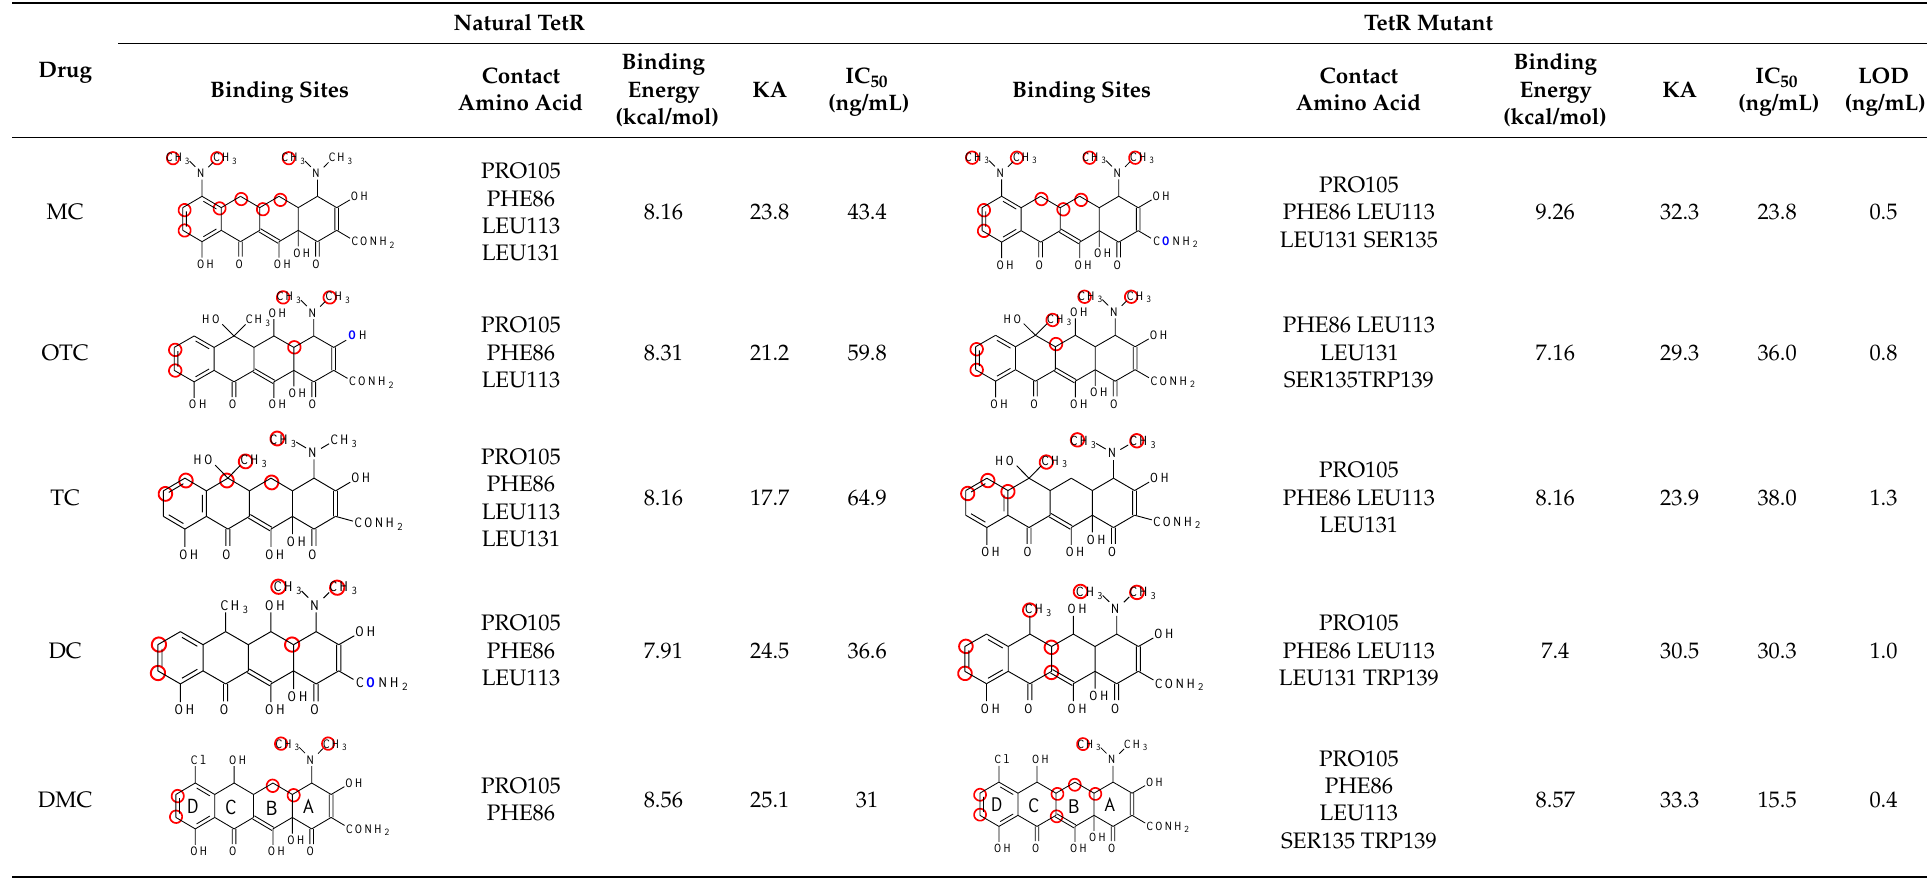
Table 1. Molecules, docking results, absolute affinity constants (KA) and determination parameters for the 10 TCs. The circled positions were the binding sites of the Table 1. Molecules, docking results,absolute affinity constants(KA) and determination parametersfor the 10 TCs. The circled positions were the binding sites of Table 1. Molecules, docking results,absolute affinity constants(KA) and determination parametersfor the 10 TCs. The circled positions were the binding sites of Table 1. Molecules, docking results,absolute affinity constants(KA) and determination parametersfor the 10 TCs. The circled positions were the binding sites of Table 1. Molecules, docking results,absolute affinity constants(KA) and determination parametersfor the 10 TCs. The circled positions were the binding sites of Table 1. Molecules, docking results,absolute affinity constants(KA) and determination parametersfor the 10 TCs. The circled positions were the binding sites of Table 1. Molecules, docking results,absolute affinity constants(KA) and determination parametersfor the 10 TCs. The circled positions were the binding sites of Table 1. Molecules, docking results,absolute affinity constants(KA) and determination parametersfor the 10 TCs. The circled positions were the binding sites of Table 1. Molecules, docking results,absolute affinity constants(KA) and determination parametersfor the 10 TCs. The circled positions were the binding sites of hydrophobic bond. The atoms highlighted with blue were the binding sites of the hydrogen bond. the hydrophobic bond. The atoms highlighted with blue were the binding sites of the hydrogen bond. the hydrophobic bond. The atoms highlighted with blue were the binding sites of the hydrogen bond. Table 1. Molecules, docking results,absolute affinity constants(KA) and determination parametersfor the 10 TCs. The circled positions were the binding sites of Table 1. Molecules, docking results,absolute affinity constants(KA) and determination parametersfor the 10 TCs. The circled positions were the binding sites of the hydrophobic bond. The atoms highlighted with blue were the binding sites of the hydrogen bond. the hydrophobic bond. The atoms highlighted with blue were the binding sites of the hydrogen bond. the hydrophobic bond. The atoms highlighted with blue were the binding sites of the hydrogen bond. the hydrophobic bond. The atoms highlighted with blue were the binding sites of the hydrogen bond. the hydrophobic bond. The atoms highlighted with blue were the binding sites of the hydrogen bond. the hydrophobic bond. The atoms highlighted with blue were the binding sites of the hydrogen bond. the hydrophobic bond. The atoms highlighted with blue were the binding sites of the hydrogen the hydrophobic bond. The atoms highlighted with blue were the binding sites of the hydrogen bond. Natural TetR TetR Mutant Drug Drug